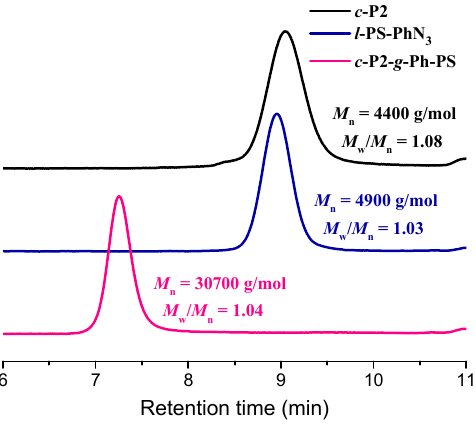
Figure 6. SEC curves of c -P2, l -PS-PhN 3 and c -P2- g -Ph-PS. THF as the eluent and PS as calibration standards.